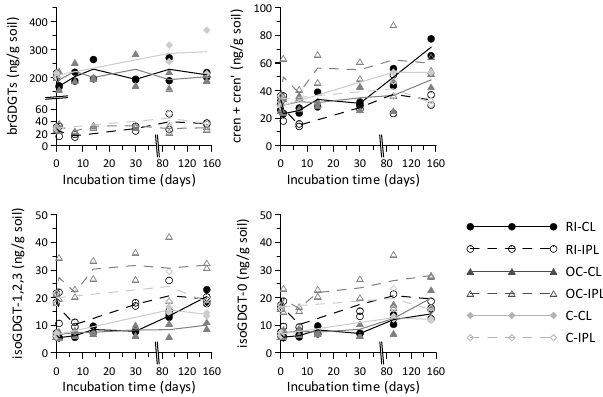
Figure 4. Concentrations of core lipid (CL) and intact po- lar lipid (IPL)-derived (a) brGDGTs, (b) crenarchaeol + cren (cid:48) , (c) isoGDGT-1,2,3, and (d) isoGDGT-0 in a sandy loam soil from the Rakaia River catchment, New Zealand, during incubation ( t = 152 days) in river (RI), ocean (OC), and distilled (C) water. Av- erage concentrations are indicated by solid (CLs) and dashed (IPL- derived)